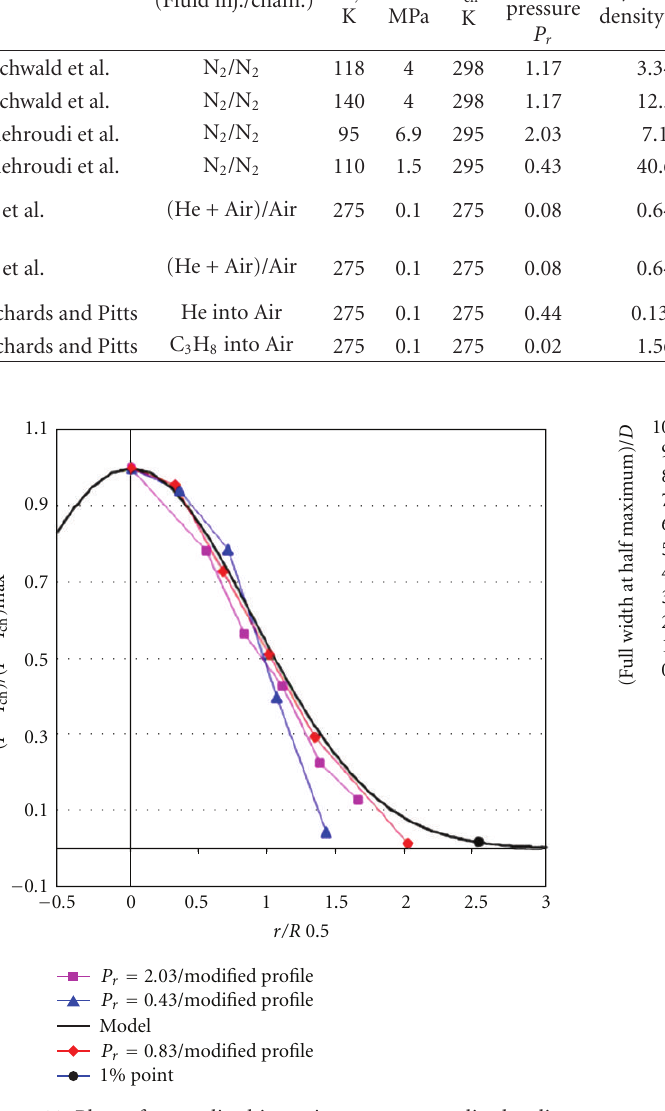
Figure 12: Normalized FWHM of the density-surplus radial profiles of single jets plotted as a function of the normalized axial distance from the injector exit plane. From Chehroudi et al.